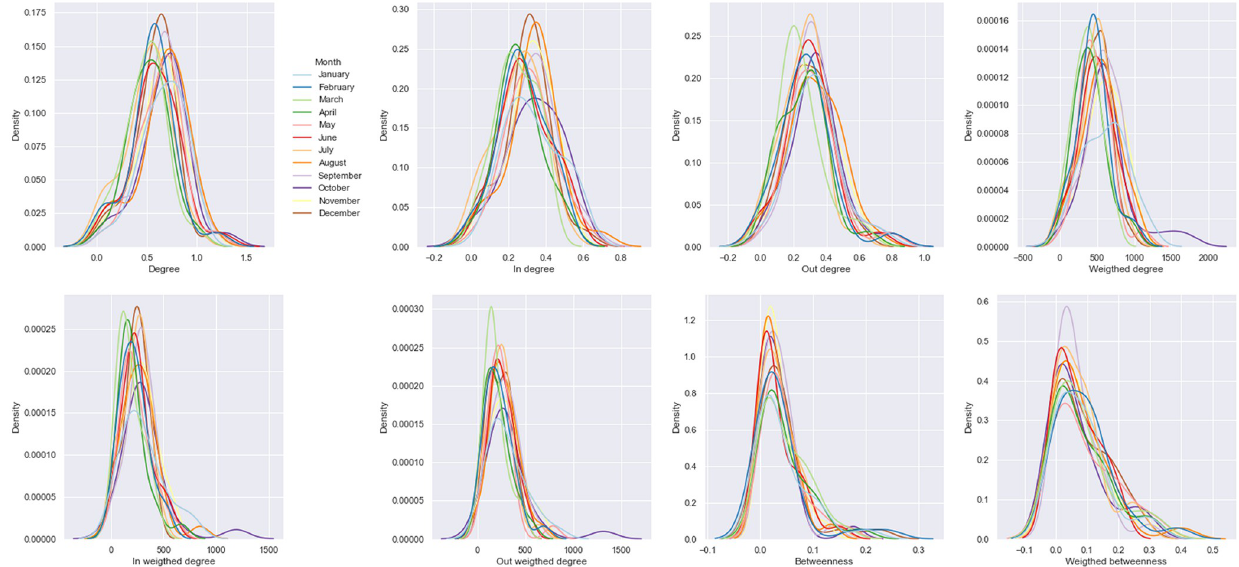
Fig 6. Distributions of different network centrality measurements. These distributions were computed per month for features related to degree and betweenness.